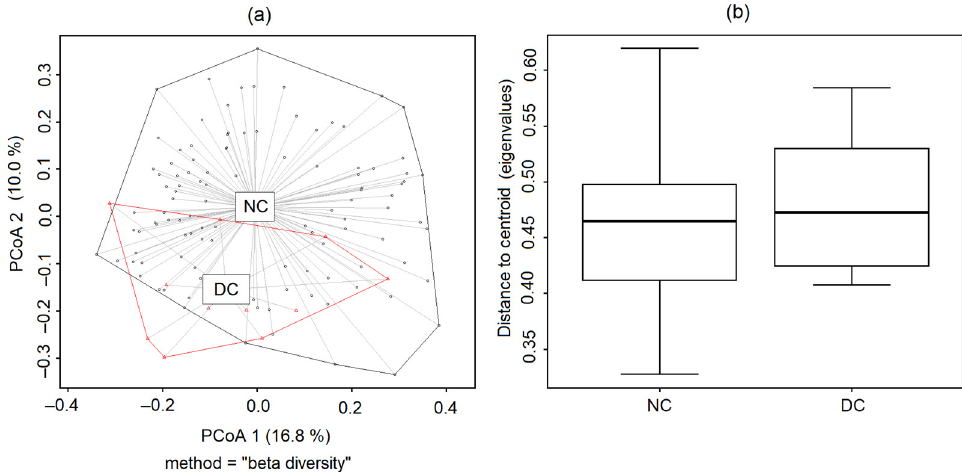
Figure 4. Principal coordinate analysis (PCoA) plot for the differences in group homogeneities based on beta diversity between phytoplankton communities during the periods of port construction (DC) and in the absence (NC) of such works ( a ); homogeneity of multidimensional dispersions of the phytoplankton community of the Neva Estuary during the periods of construction (DC) and in the absence (NC) of hydrotechnical works ( b ); the thick line is the average distance to the median value of the variance of beta diversity, the block boundaries are for the variance of beta diversity for frequently occurring species, the black lines are the variance of all community species.